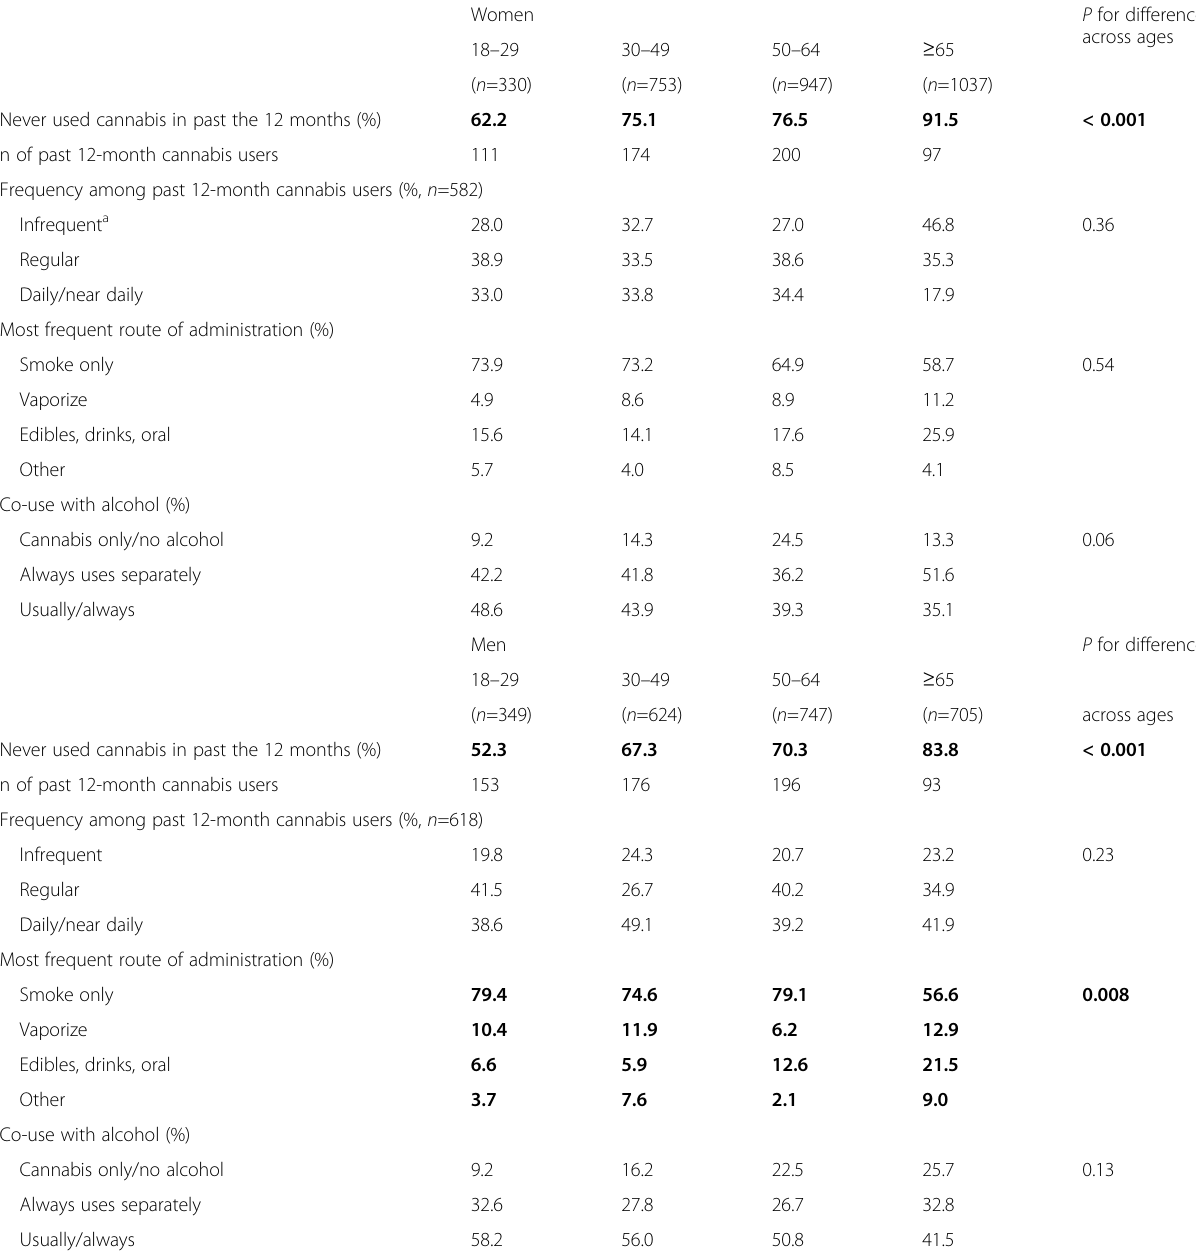
Table 1 Past 12-month prevalence of cannabis use frequency, route of administration, and co-use with alcohol across gender by age subgroups, 2014 – 2016 Washington state general population ( N =